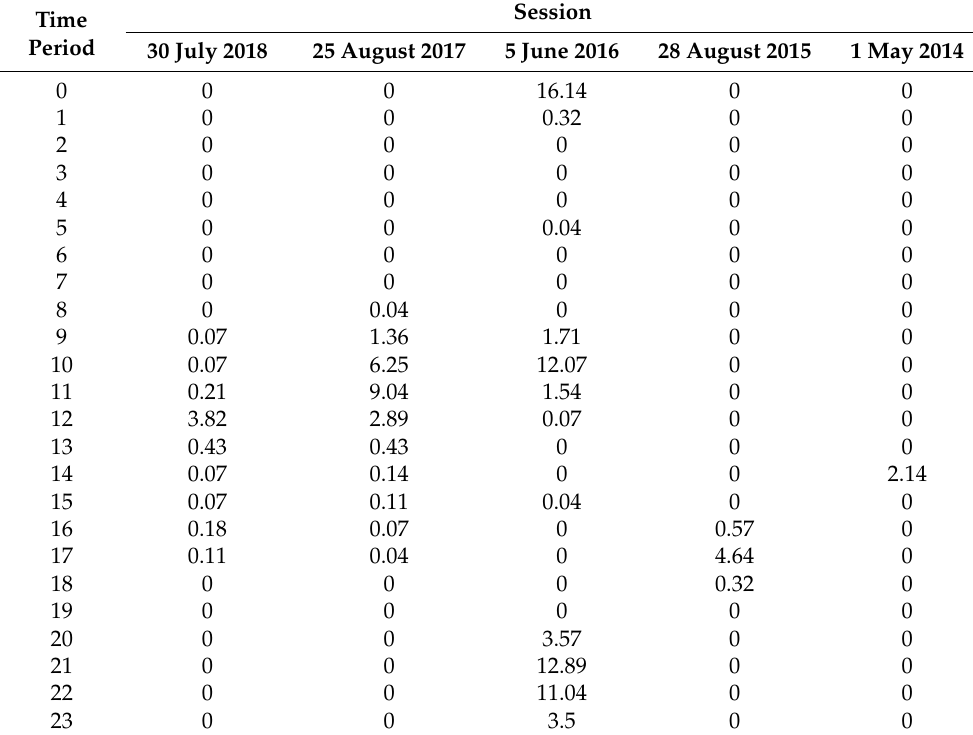
Table 2. Part of the measured rainfall data. Units of the measured rainfall are in millimeters. Time